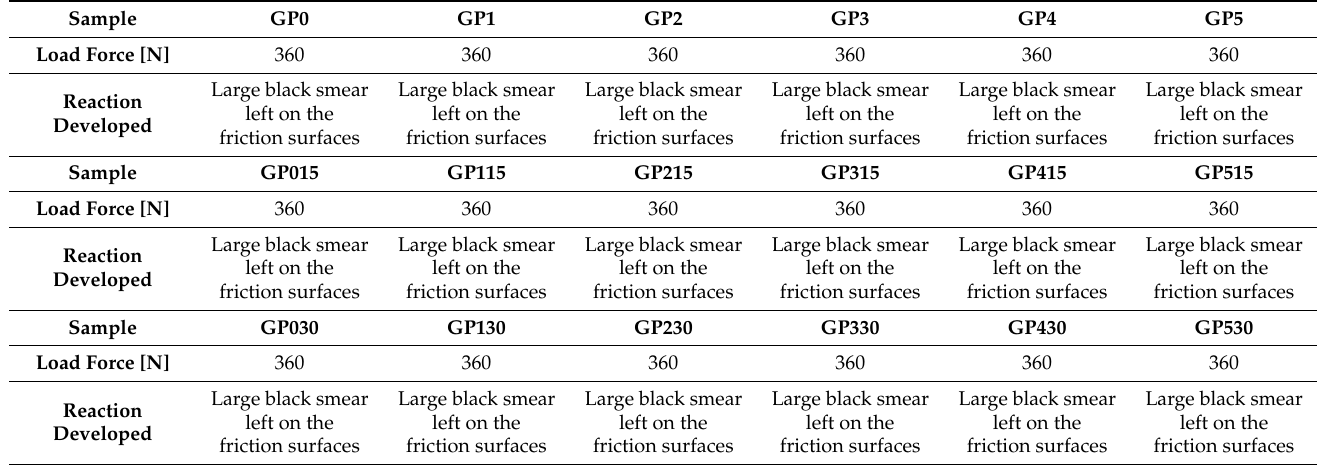
Table 10. Mechanical sensitivity to impact stimuli of “green” formulations.